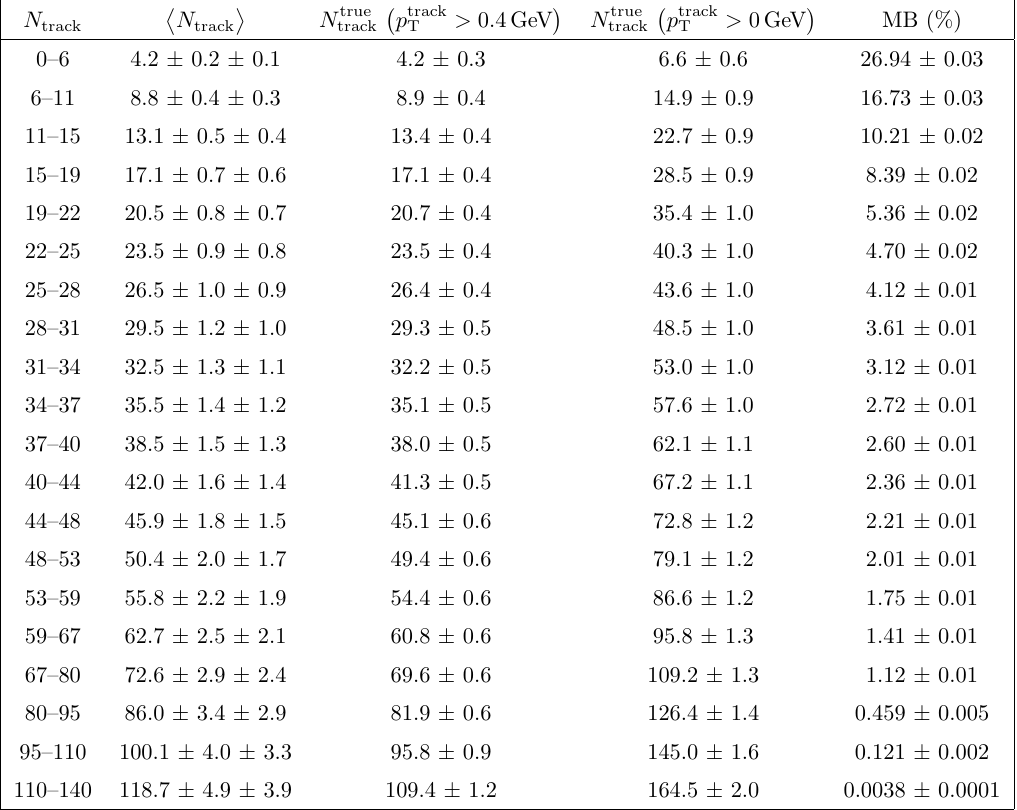
Table 1 . E(cid:14)ciency-corrected multiplicity bins used in the (cid:7) (nS) ratio analysis and the corre- sponding mean number of charged particle tracks with p track most probable values of the two half-Gaussian (cid:12)t to the corresponding N true p track